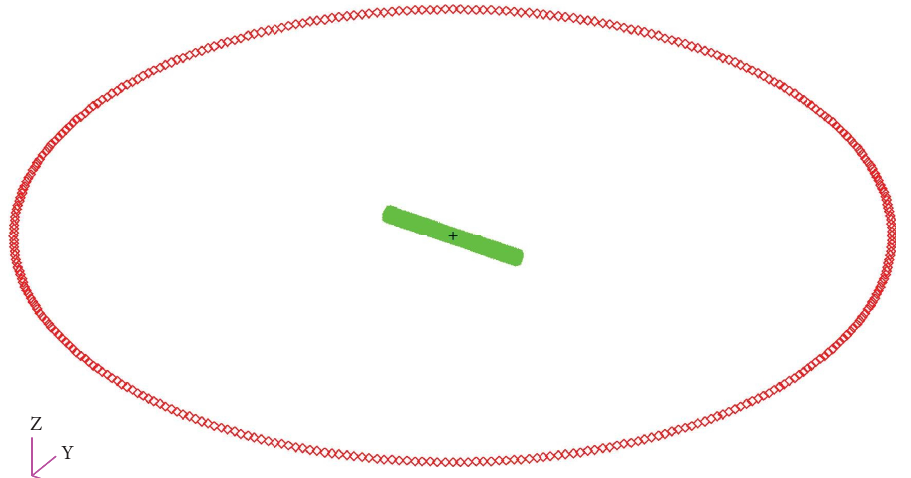
Figure 11: Boundary elements and acoustic feld points in